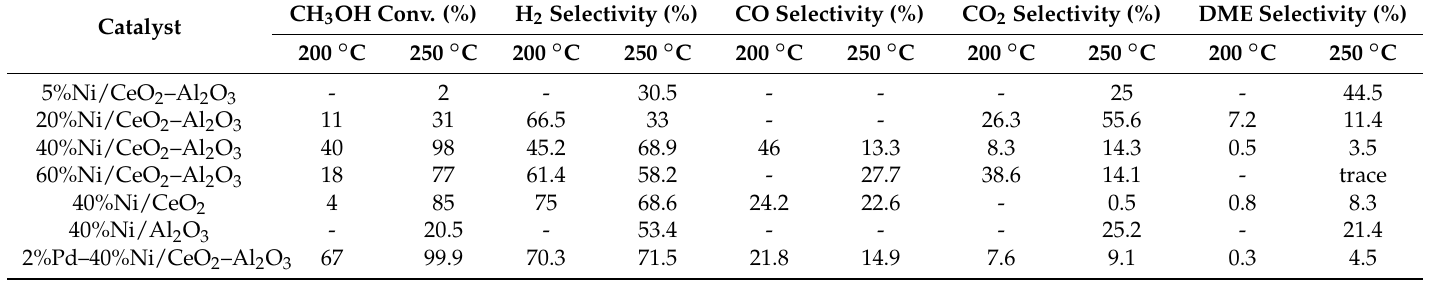
Table 1. Effect of temperature on the catalytic activity and selectivity to hydrogen, carbon monoxide, carbon dioxide, dimethyl ether (DME) in oxy-steam reforming of methanol over monometallic Ni catalysts supported on Al 2 O 3 , CeO 2 , CeO 2 –Al 2 O 3 and bimetallic Pd–Ni catalysts supported on binary oxide CeO 2 –Al 2 O 3 . Reaction condition: weight of catalyst = 0.2 g, H 2 O/CH 3 OH/O 2 molar ratio in the reaction mixture = 1/1/0.4, temperature of the reaction 200 and 250 °C. The catalytic tests were